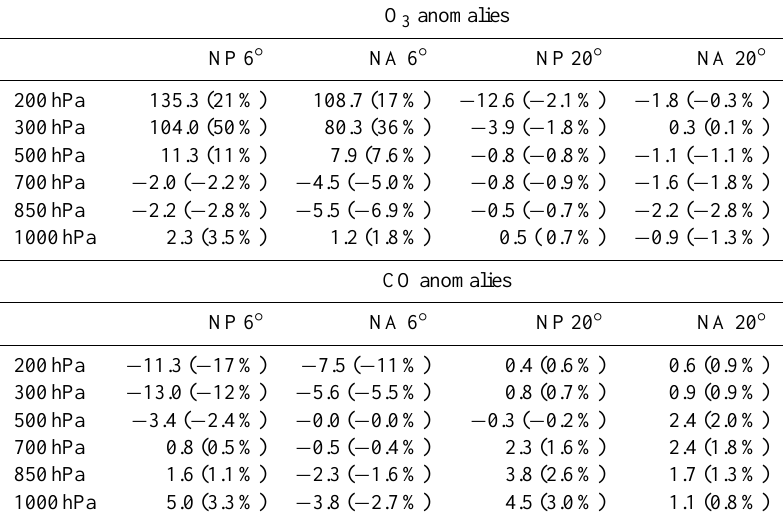
Table 1. Anomalies of aavg-O 3 (top; ppb) and aavg-CO (bottom; ppb) of storm-centered composite minus background composite at different radii: 6 and 20 ◦ . Percent difference relative to the background composite is given in the